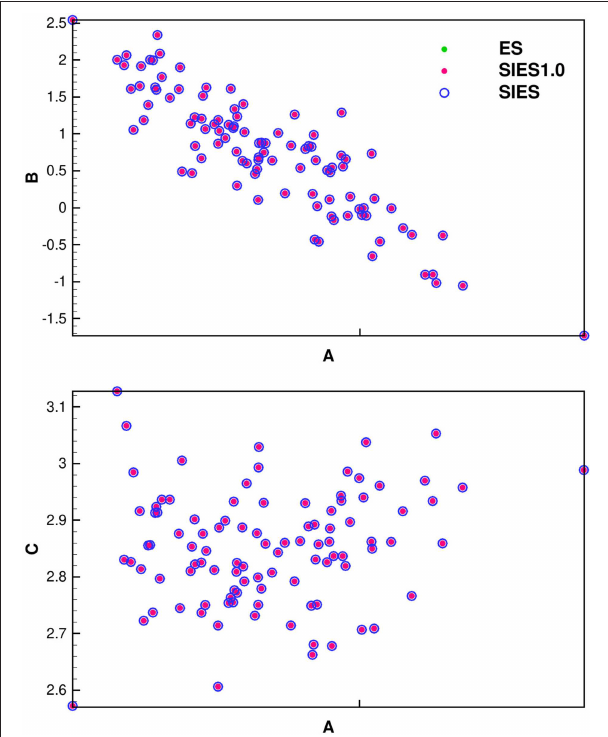
FIGURE 4 | SIES verification using cross plots of coefficients a , b , and c for the polynomial Gauss-linear case. The solution using Ensemble Smoother (ES) and SIES with step length 1.0 (SIES1.0) are identical for each realization. The SIES converges to the ES solution as well (the result is shown after 12